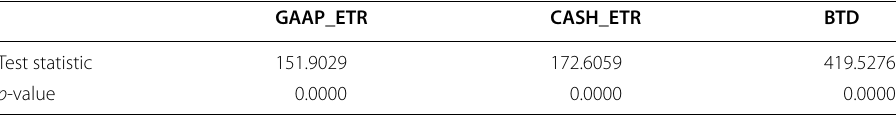
All variables are defined in the Appendix